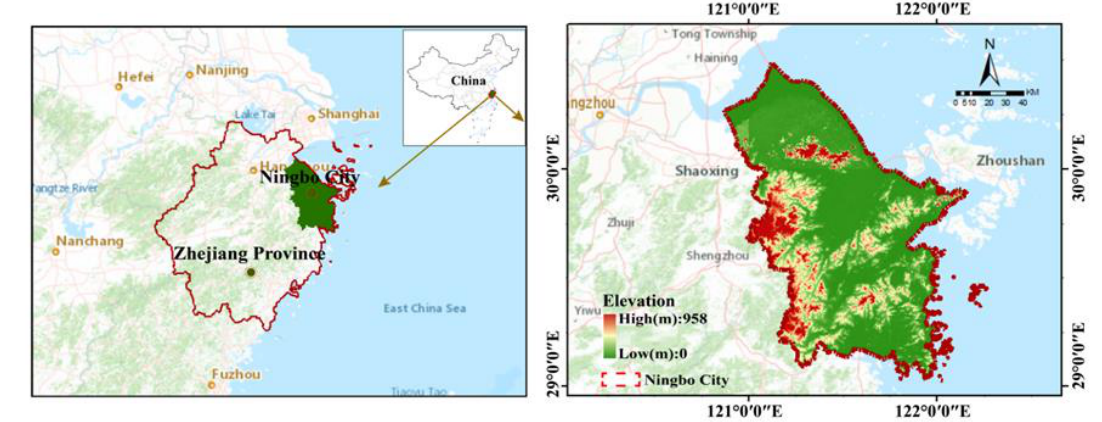
Figure 1. Geographical location of Ningbo City.